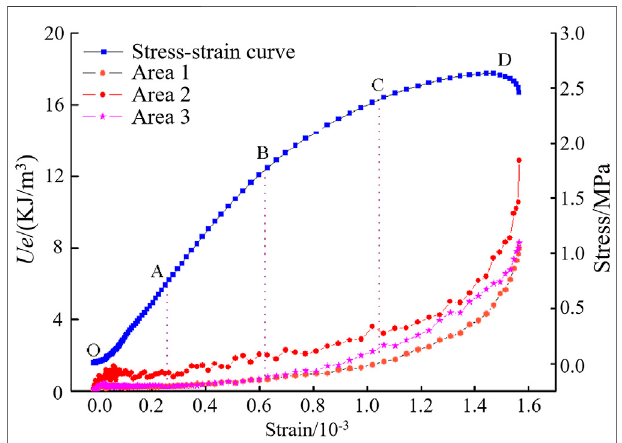
FIGURE 8 | Elastic strain energy evolution of S1 specimen.